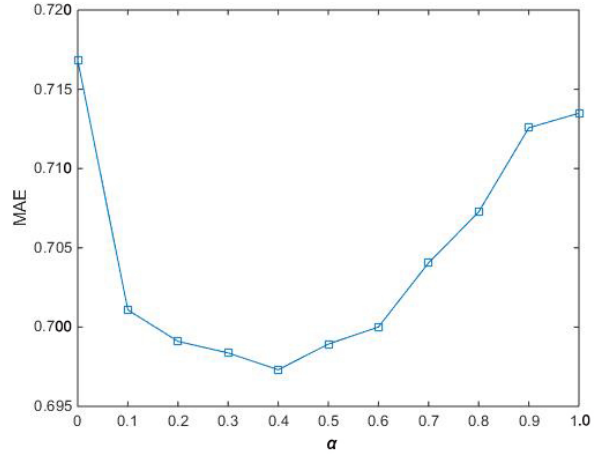
Fig. 1 Effect of parameter ˇˇˇ on MAE of TT-UserCF algorithm.